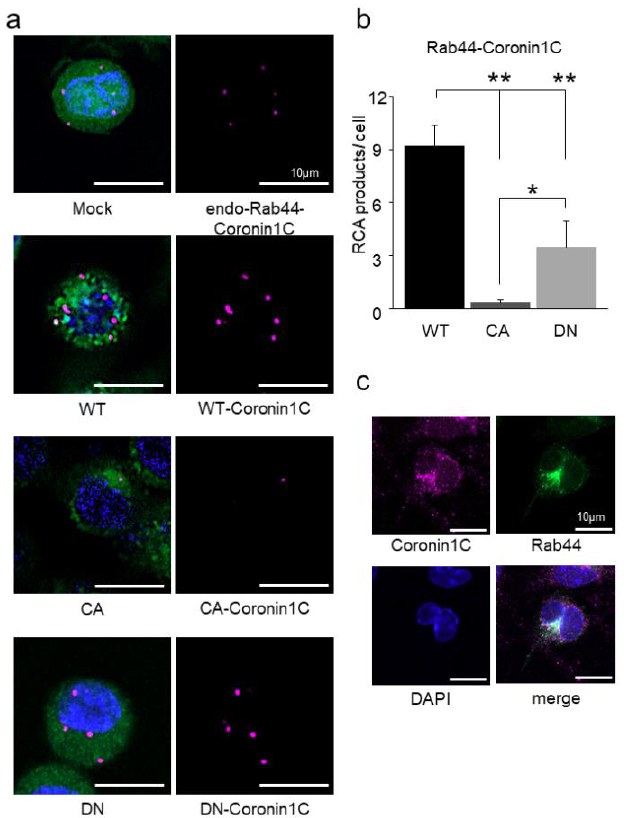
Figure 2. Proximity ligation assay of the interaction between Rab44 and Coronin1C. ( a ) Detection of proximity ligation signals between Rab44 and Coronin1C in RAW-D cells using a confocal microscope. GFP proteins in Rab44 (WT, CA, DN) with GFP tag expressing cells were fluorescently detected as green, rolling circle amplification (RCA) products of Rab44 and Coronin1C were detected as magenta, and DAPI was detected as Blue (nuclei). Bar: 50 µ m. ( b ) Quantitative analysis of the number of the RCA products in a cell using ImageJ software. Data are expressed as mean ± SD ( n = 4). * p <0.05, ** p <0.01. ( c ) Localization of Rab44 and Coronin1C in bone marrow-derived macrophages (BMMs) using confocal microscopy. BMMs were cultured in M-CSF (30 ng/mL) and RANKL (100 ng/mL) for three days, followed by immunofluorescent staining with Rab44 and Coronin1c antibodies. Coronin1C (Magenta), Rab44 (Green), and the nuclei (Blue).